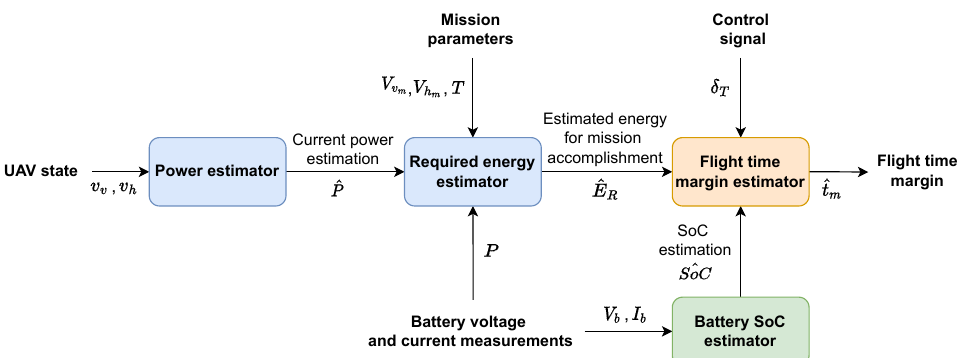
Figure 1. Overview of the available energy and flight time estimation process. The system consists of three sections, energy estimation, battery-charge estimation, and flight-time-margin